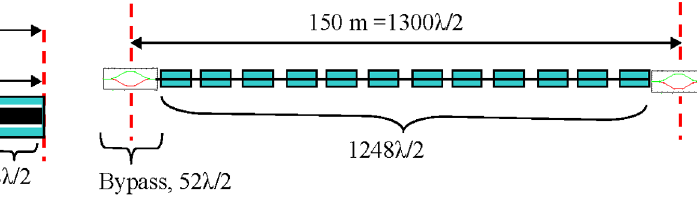
FIG. 12. (Color) Cryomodule housing four SSTs. Space for focusing elements (quads) and beam position monitor is marked as a black bar on the TABLE III. Estimated normalized energy loss (in %) for the nominal beam at various energies. Final energy